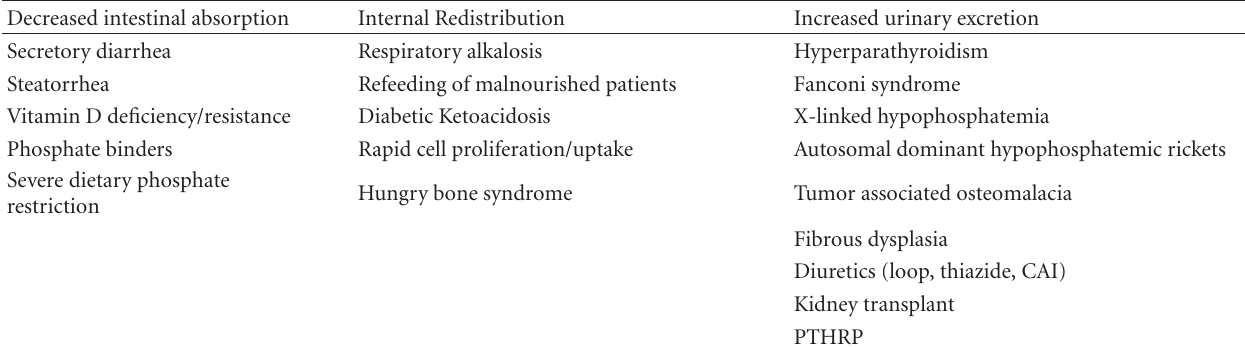
∗ Table adapted from